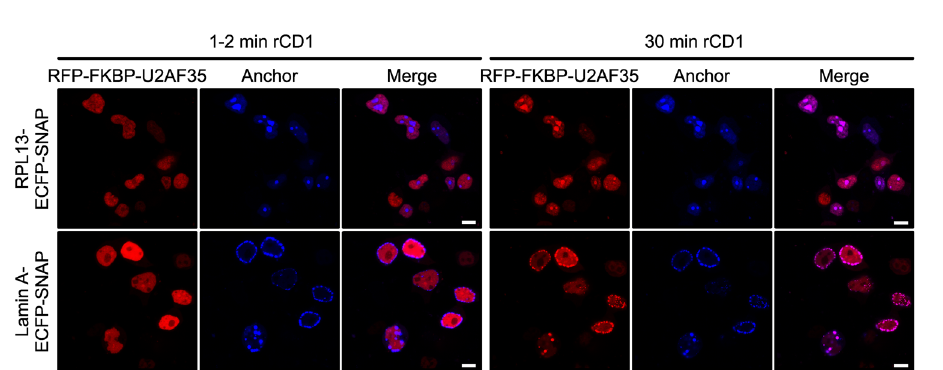
Fig. 3 rCID-mediated re-localization of U2AF35. Time-dependent, rCD1-mediated recruitment of the RFP-FKBP-U2AF35 target protein fusion (red channel; left) to the RPL13-ECFP-SNAP (top panels) or lamin A-ECFP-SNAP (bottom panels) anchor protein fusion (blue channels; middle), monitored via live-cell confocal microscopy. Right panels in each group, merged images. The same cells were imaged 1 – 2 min (left groups of three images) and 30 min (right groups of three images) after the addition of rCD1. Scale bars (10 μ m) are shown as white lines on the bottom right of the merged